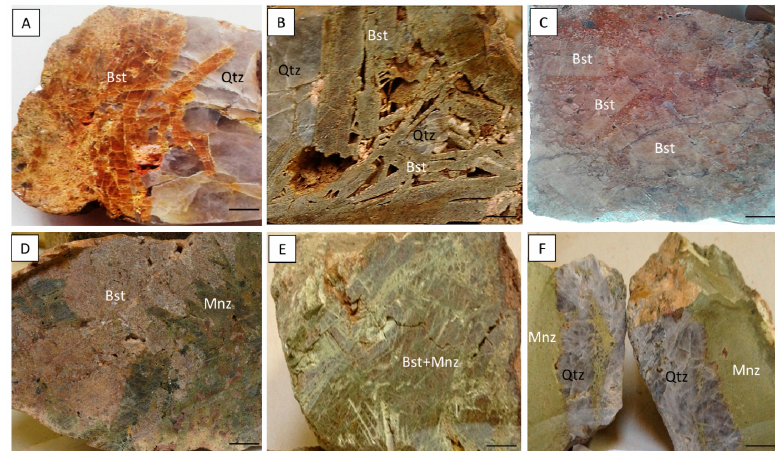
Figure 10. Representative samples of the Gakara REE deposits: ( A ) GOMV sample exhibits a bastnaesite ore cutting a quartz vein (likely Kibaran in age); ( B ) KIV sample displays deformed crystals of bastnaesite (Bst) with holes filled by quartz (Qtz); ( C ) NYARU sample is a breccia consisting of clasts of bastnaesite in a pinkish matrix; ( D ) GASH sample shows the replacement of bastnaesite by monazite; ( E ) GASA sample is typical of an altered ore with monazite together with bastnaesite relics; ( F ) MURA sample shows a monazite (Mnz) ore associated with a quartz vein. Mineral abbreviations according to [27,28]. The black bars at the bottom right corners correspond to 2